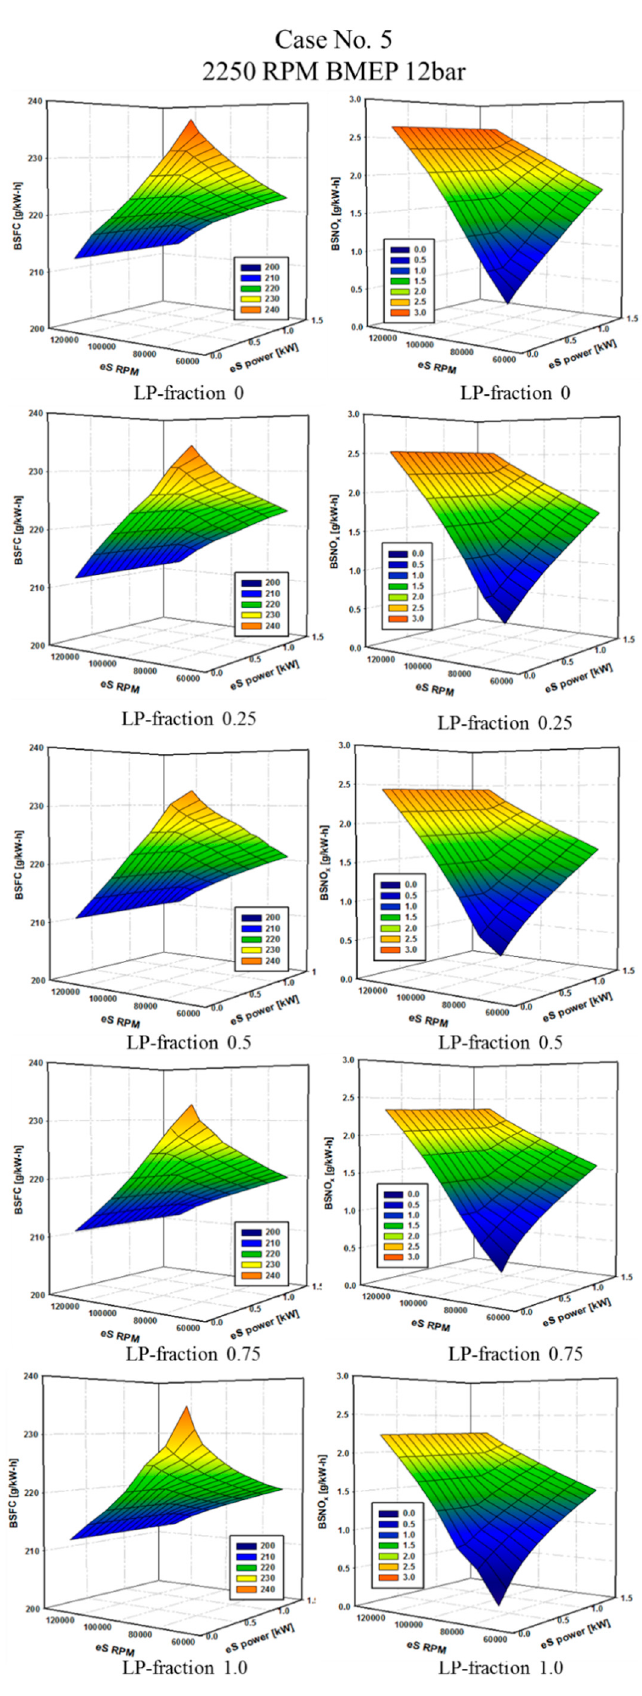
Figure 10. Response surface plots for BSFC and BSNO x in case 5 for each LP fraction.